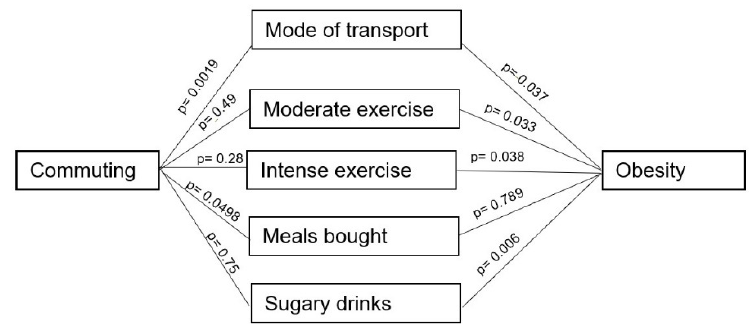
Figure 1. Possible mediators in the association between obesity and commuting.